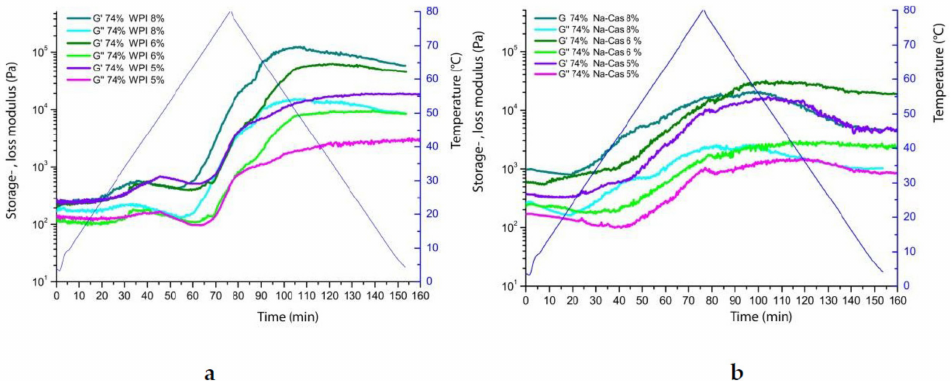
Figure 14. Storage modulus ( G ’) and loss ( G’ ’) modulus and loss moduli of under temperature increase and decrease (4 ◦ C to 80 ◦ C to 4 ◦ C) of reconstructed emulsions with 74% oil and increasing WPI ( a ), and Na-Cas ( b ) concentrations (from 5 to